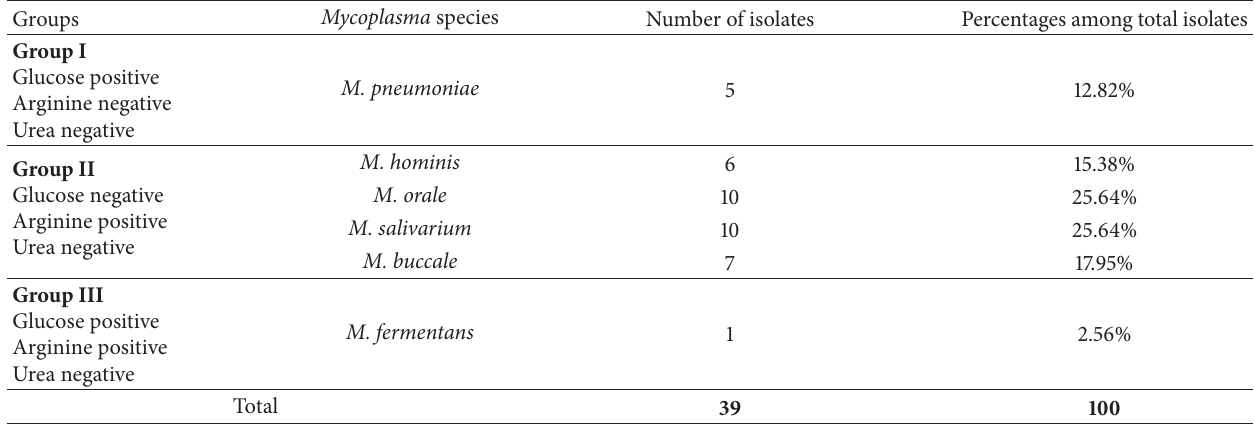
Table 1: Classification of the isolated Mycoplasma species into three groups according to biochemical tests.